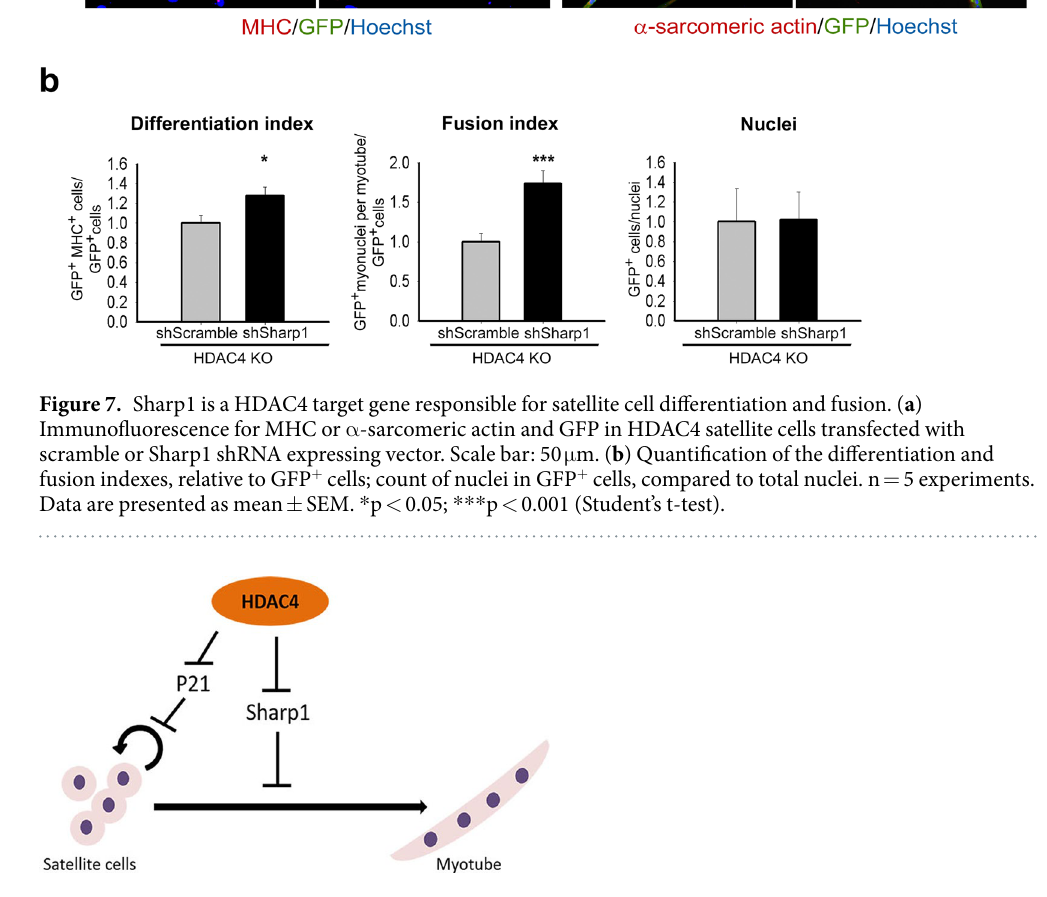
Figure 8. Working model of HDAC4 function in satellite cells. During proliferative stage, HDAC4 represses P21 and Sharp1 expression, thereby regulating satellite cell proliferation and